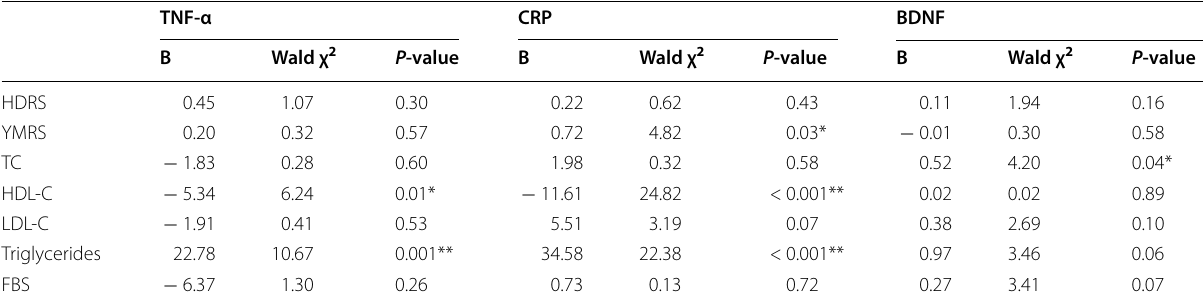
Table 4 Correlation between TNF-α, CRP, and BDNF with clinical symptoms and metabolic parameters